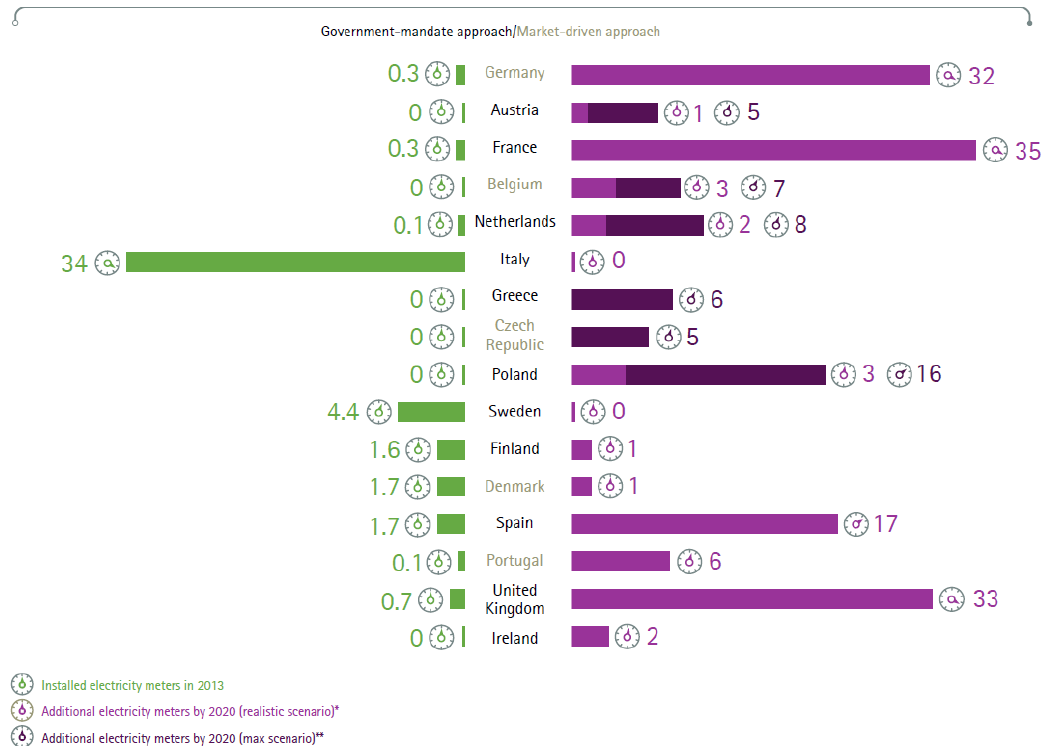
Figure 5. Estimation of the total number of SM s installed in Europe by 2020 (Source: Accenture [55]). Reprinted with the permission of Accenture, “Realizing the Full Potential of Smart Metering ”, published by Accenture, 2015.